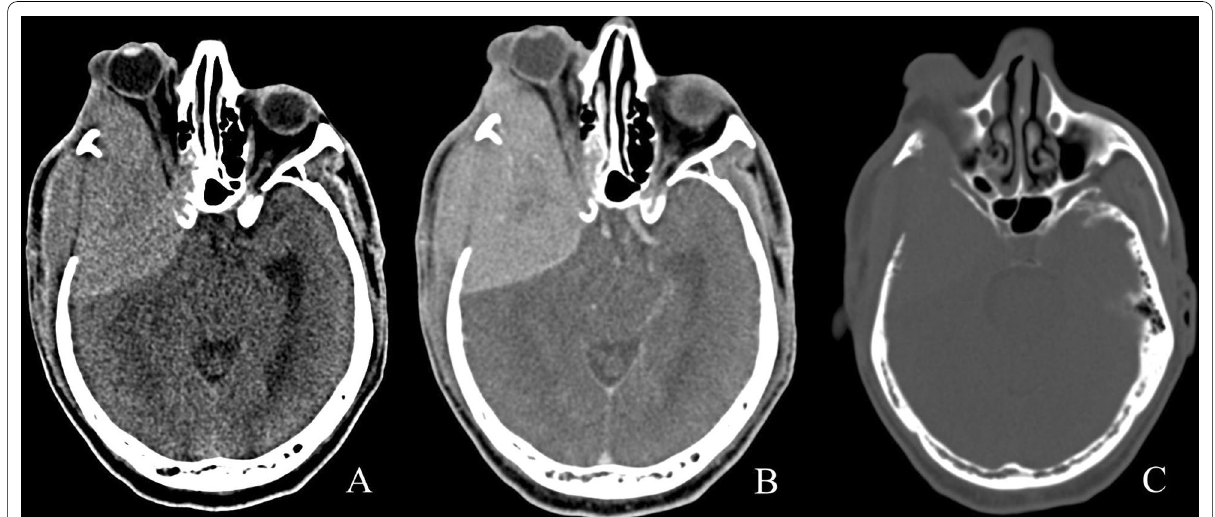
Fig. 1 Preoperative CT scan of the brain and skull base. CT brain axial views, pre ( A ) and post ( B ) contrast administration, revealing right skull base tumour arising from region of sphenoid wing, and extending into orbit and temporalis muscle. Axial bone window ( C ) showing degree of bony erosion of temporal bone and skull